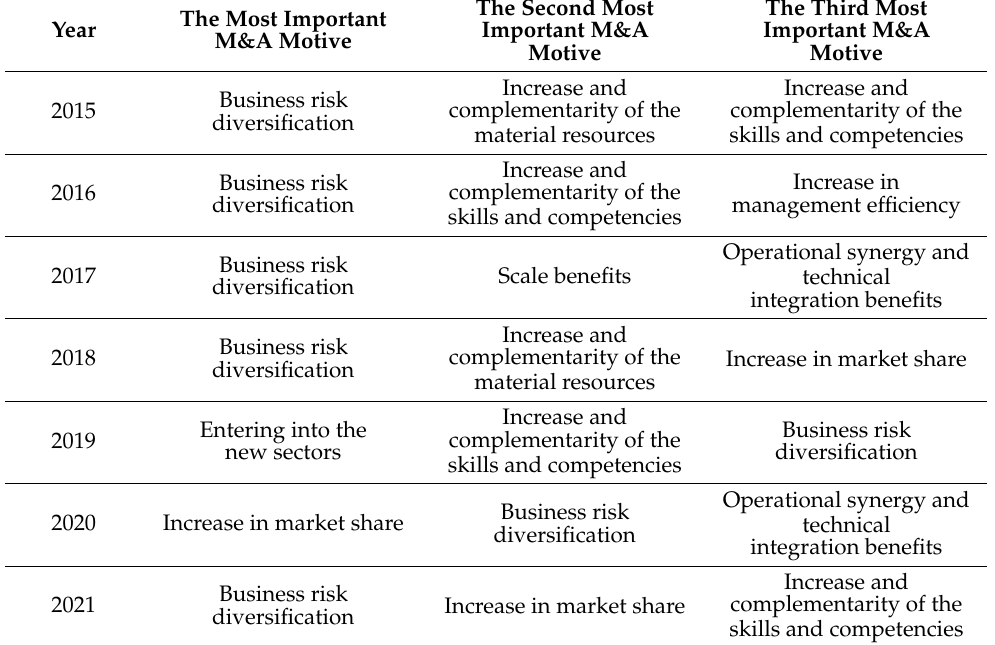
Table 2. The most important M&A motives identified in M&A transactions in the research sample, grouped by